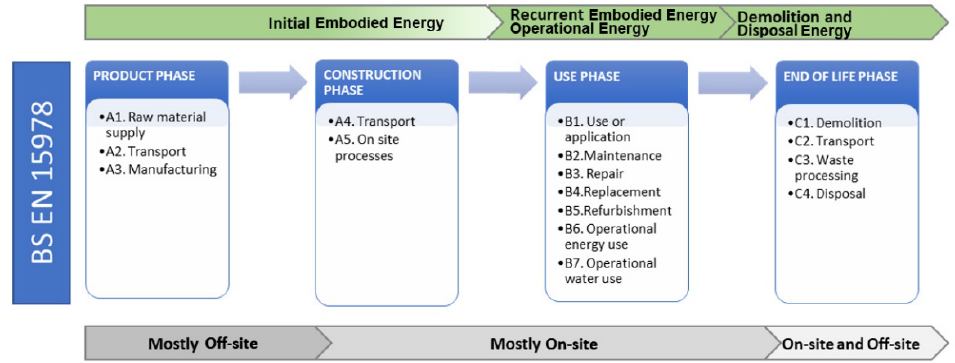
Figure 1. Life cycle stages of a building as defined by BS EN 15978 and associated energy.